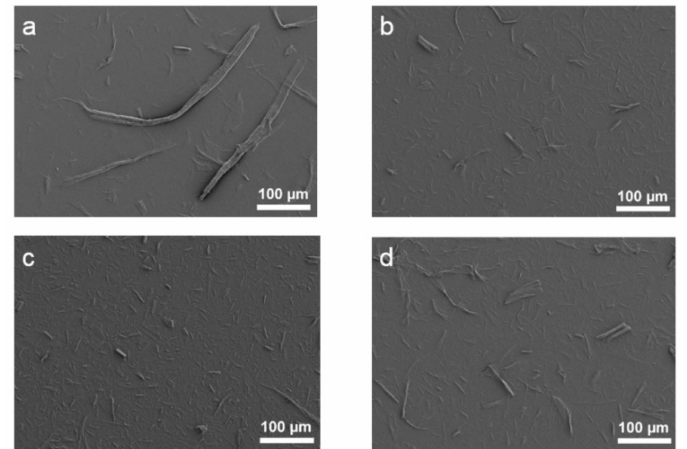
Figure 3. SEM micrographs of CNF samples obtained after TEMPO oxidation and microfluidization of: ( a ) bleached birch kraft pulp (BBK); ( b ) bleached kraft pulp extracted with water at 240 ◦ C for 2 min (BBK240.2); ( c ) bleached kraft pulp extracted with water at 240 ◦ C for 10 min (BBK240.10); ( d ) unbleached kraft pulp extracted with water at 240 ◦ C for 10 min